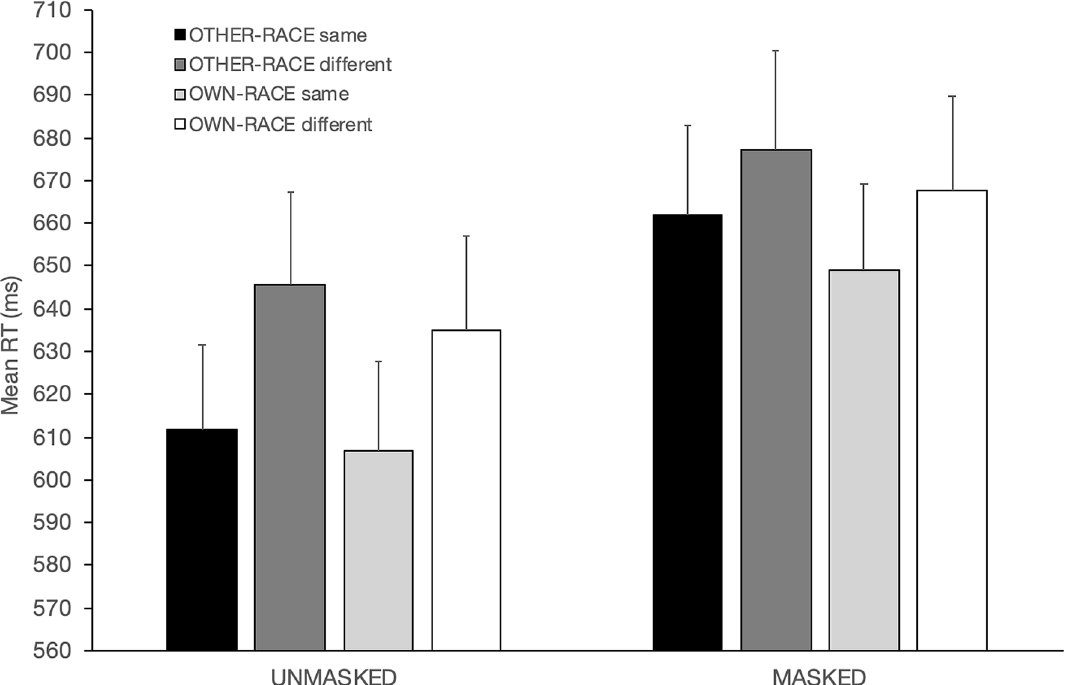
Figure 1. Mean reaction times to target faces separately for the unmasked (left panel) and masked (right panel) procedures as a function of prime-target identity (same vs different) and race (other-race vs own-race). Error bars represent standard errors of the mean.